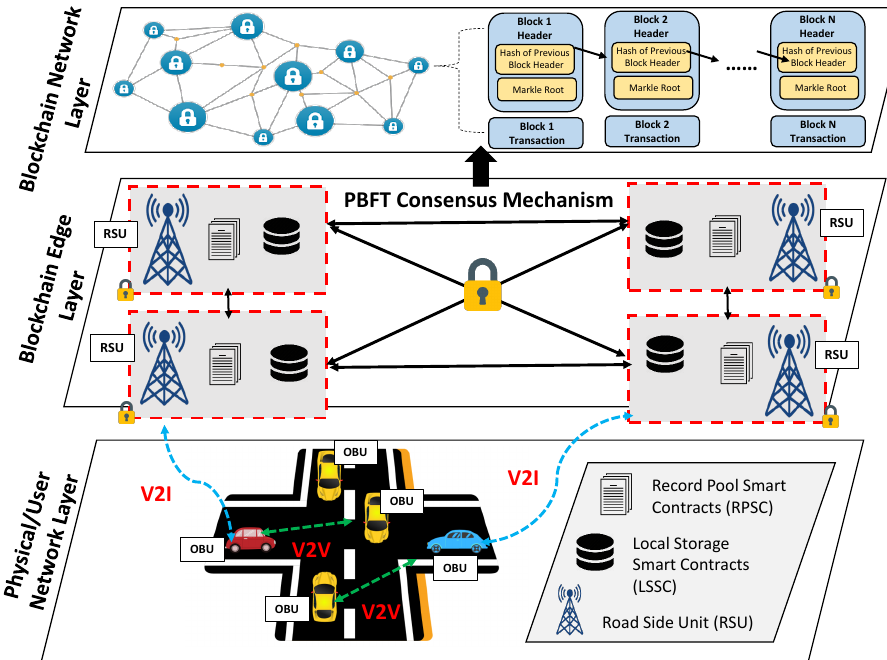
Figure 1. Overview of design